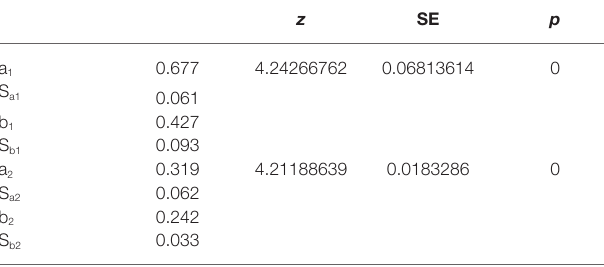
TABLE 4 | Sobel test results (model